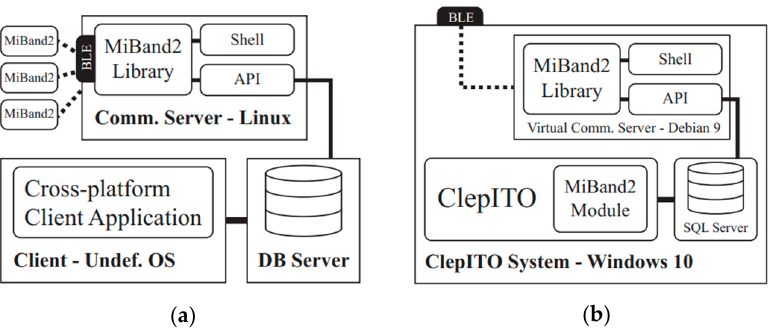
Figure 1. ( a ) Initial design for the full system’s architecture. Each element is encapsulated on it’s own subsystem and interconnected by local or external networks for maximum flexibility. ( b ) Final design for the full system’s architecture. All of the elements are packed under the same super-system due to project’s requirements and for ease of replication